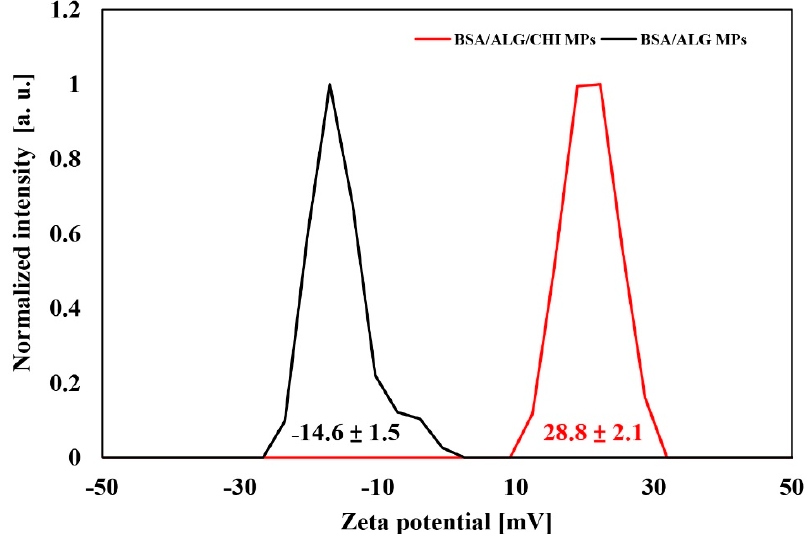
Figure 4. Zeta potential measurements for BSA-loaded alginate MPs (BSA/ALG MPs, black) and chitosan-coated BSA/ALG MPs (BSA/ALG/CHI MPs, red).